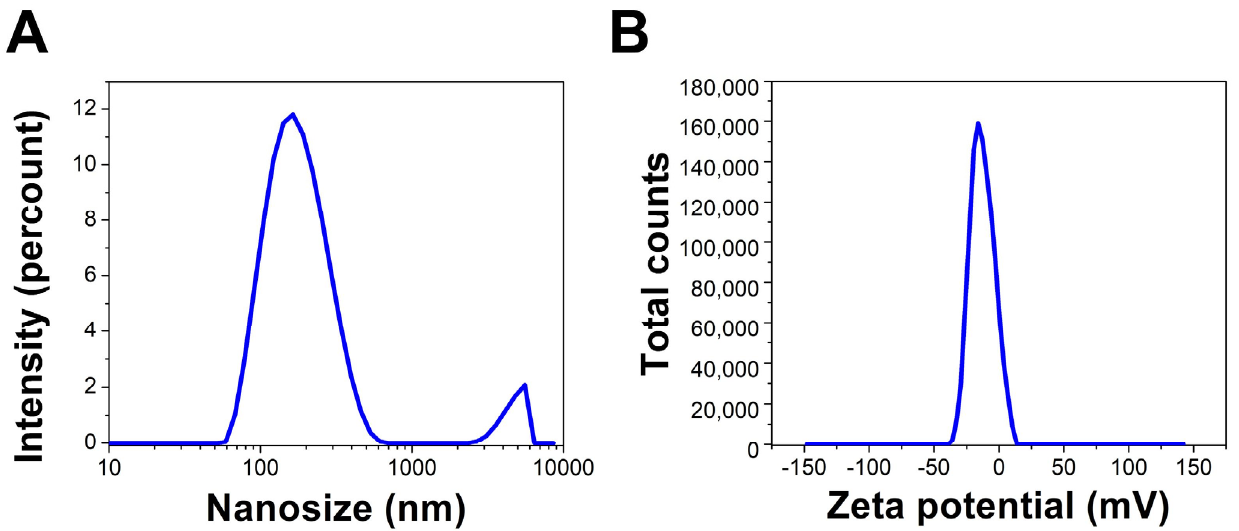
Figure 9. DLS ( A ) and zeta potential ( B ) of Uv@Ag-NPs synthesised from the unicellular ulvophyte sp. MBIC10591.